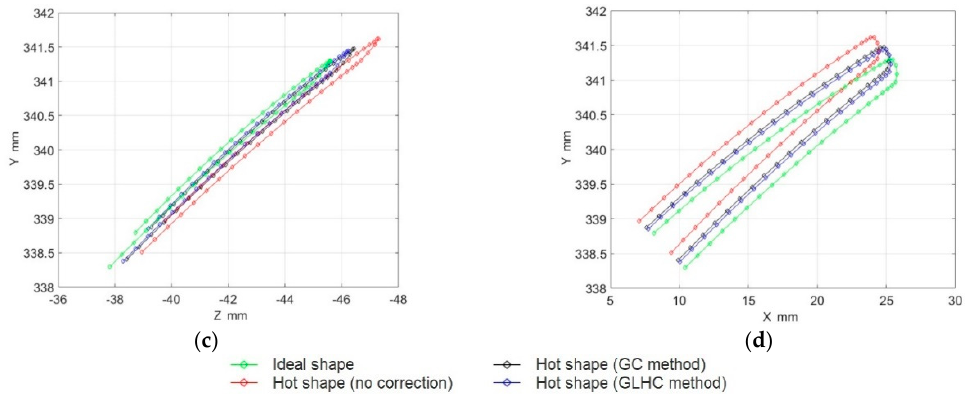
Figure 5. Comparison of the node positions on the top trailing edge of the blade in the first iteration step. ( a ) Spatial positions of the nodes; ( b ) projection of the nodes on the XZ plane; ( c ) projection of the nodes on the XY plane; ( d ) projection of the nodes on the XY plane.